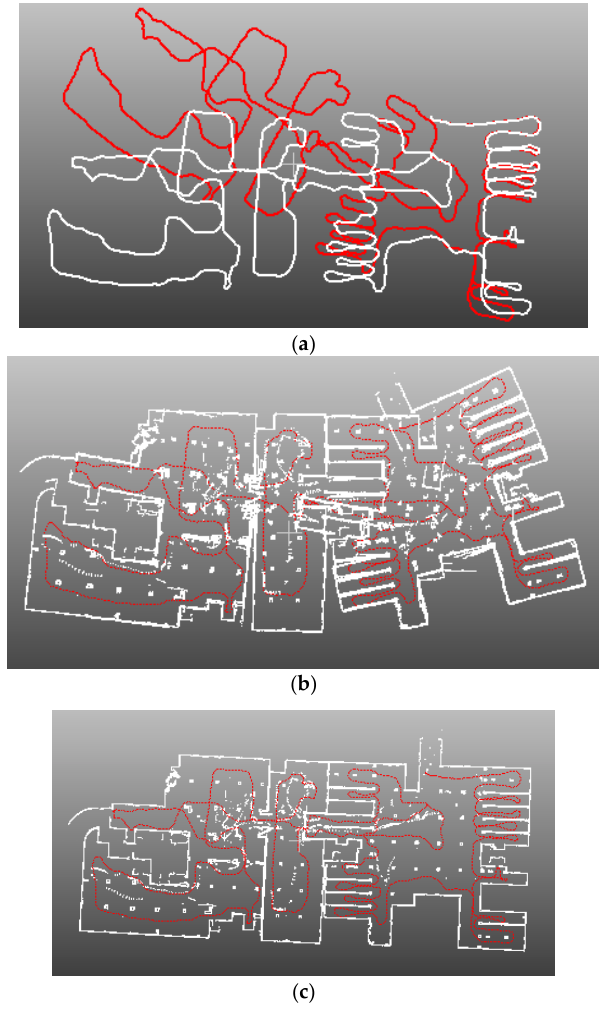
Figure 12. ( a ) trajectory comparison. Red line is the trajectory of our method before Gmapping refinement; white line is the result after refinement; ( b ) 2D map built by trajectory without refinement; ( c ) 2D map built by trajectory with Gmapping refinement.